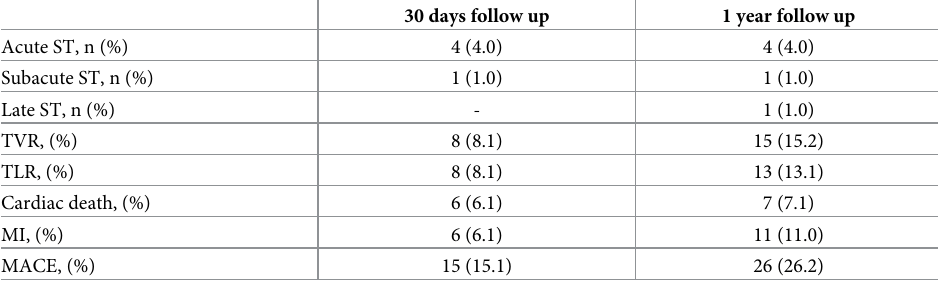
ST- sent thrombosis; TVR- target vessel revascularization; TLR- target lesion revascularization, CV- cardiovascular, MI- myocardial infarction, MACE: major adverse cardiac